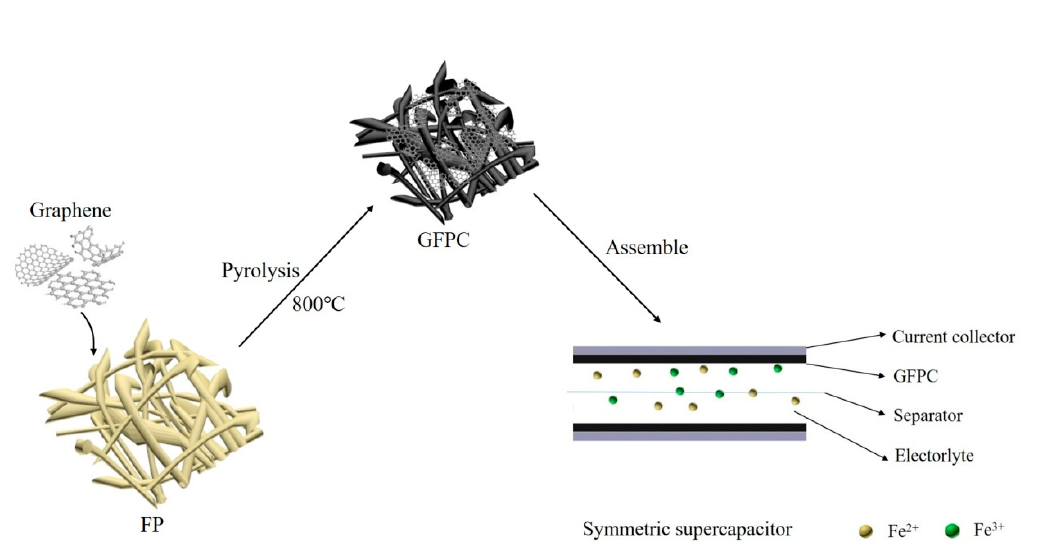
Figure 2. Illustrative schematic of the fabrication of the graphene modified carbon electrode and supercapacitors. Cellulose filter paper was used as the polymer precursor for the carbon paper